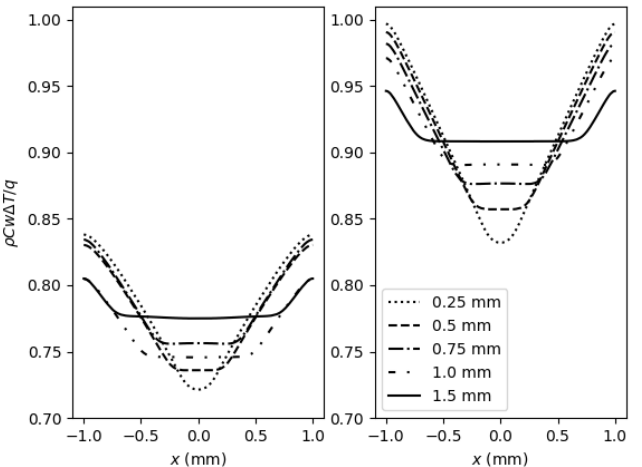
Figure 9. Temperature profile along x –transect at bottom of silicon at y = 0. Left: w 2 t / ( 4 α ) = 10.29; Right : w 2 t / ( 4 α ) = 1023.4.